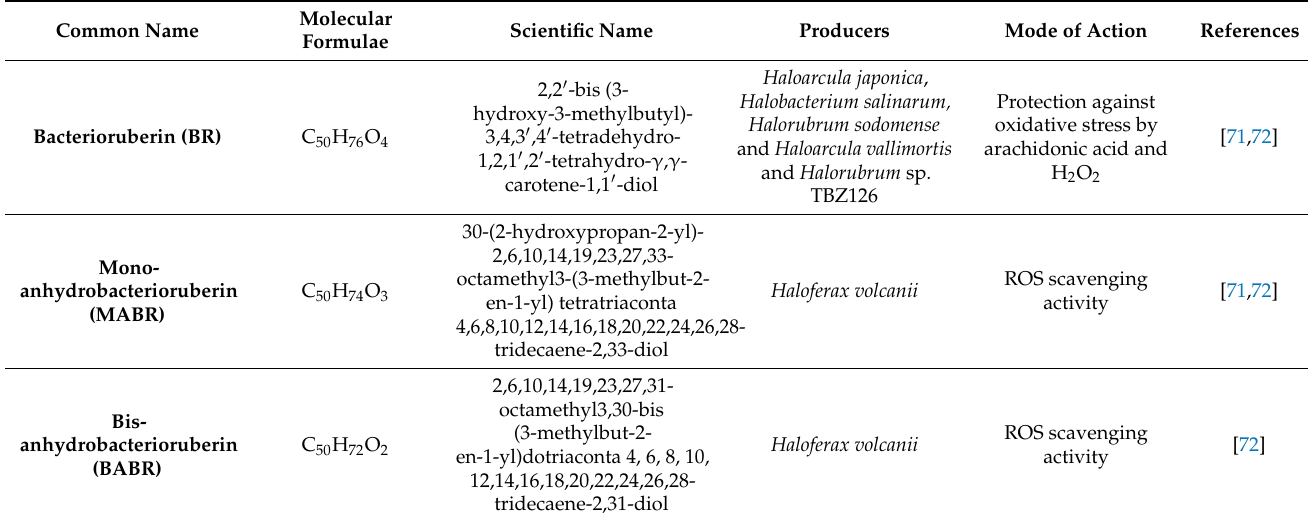
Table 2. Characterization of bacterioruberin, and its most abundant